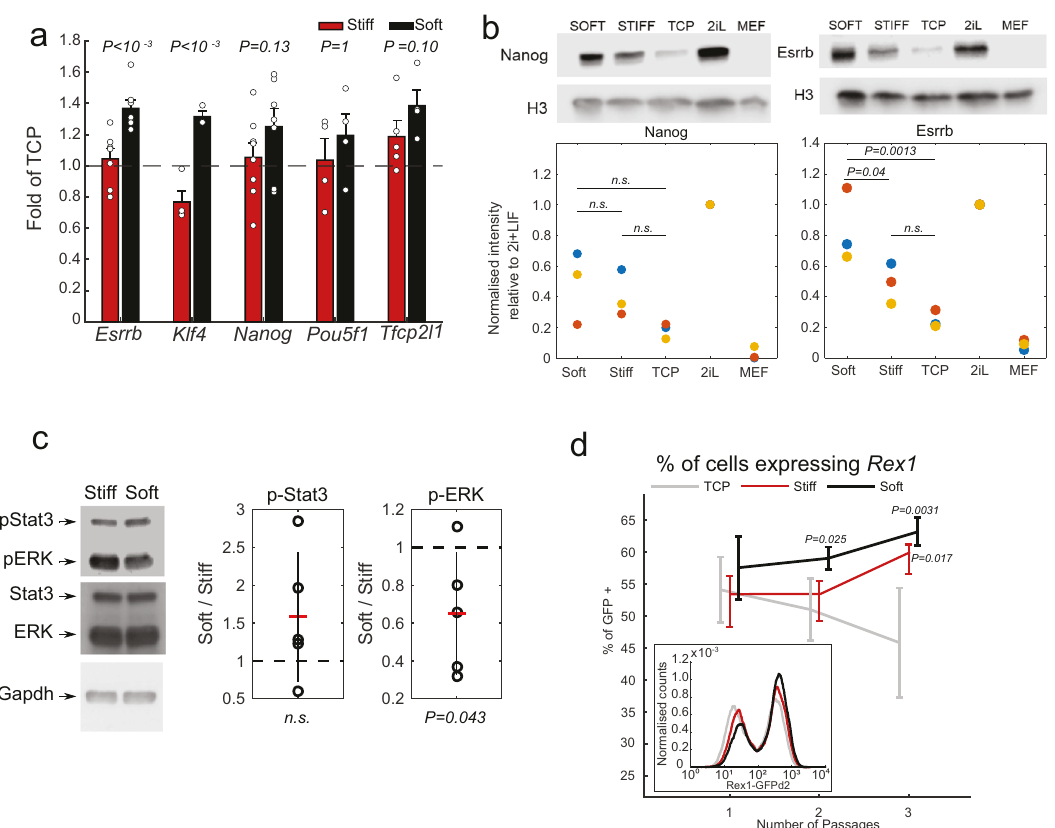
Fig. 3 StemBond substrates support pluripotency. a Mean and standard deviation of mRNA expression of selected pluripotency genes on soft and stiff (mid AHA) substrates normalised to TCP. Cells were seeded on the substrates for 24 h in serum + LIF. The P -values show the signi fi cant differences in expression between soft and stiff substrates (one-way ANOVA). Expression was averaged over n = 4 – 6 independent experiments, points show the value of independent repeats. b Quanti fi cation of NANOG (left) and ESRRB (right) on different substrates from Western blots. Scatter plots show normalised band intensity from three independent experiments. Cells were cultured for 48 h in serum + LIF on fi bronectin-coated TCP, soft and stiff hydrogels. Intensity were normalised to protein levels in 2i + LIF (2iL). Mouse embryonic fi broblasts (MEFs) were used as negative controls. P -values are from one- way ANOVA test. c (Left) Western blots for phospho-STAT3, phospho-ERK, total STAT3 and total ERK from cells grown on soft and stiff gels for 24 h in serum + LIF. GAPDH was used as loading control. (Right) Mean± std of the ratio of intensity of soft/stiff after normalisation to GAPDH ( n = 5 independent experiments). P -value computed using a one-way ANOVA. d Average percentage of reporter line Rex1 positive cells determined from fl ow cytometry histograms. Cells were cultured in serum + LIF on TCP (grey), and on soft (black) and stiff (red) high AHA substrates ( n = 4 independent experiments). P -values from two-way ANOVA are indicated. Bars show mean ± standard deviation. Inset: Corresponding example of fl ow cytometry pro fi les. For each condition, histograms of three replicate samples were averaged and smoothed. Gating strategy show in Supplementary Fig. 4a. Source data are provided as a Source Data fi